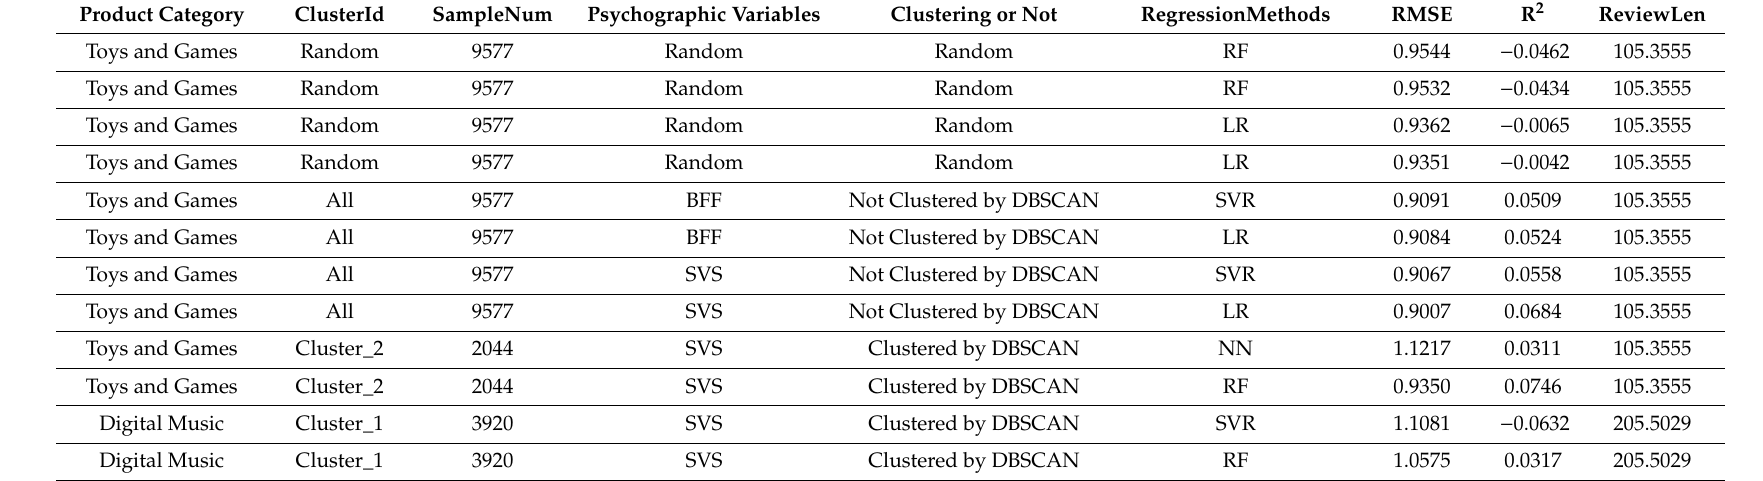
Table 4. Evaluation results of user preference prediction under di ff erent experimental settings (partial part